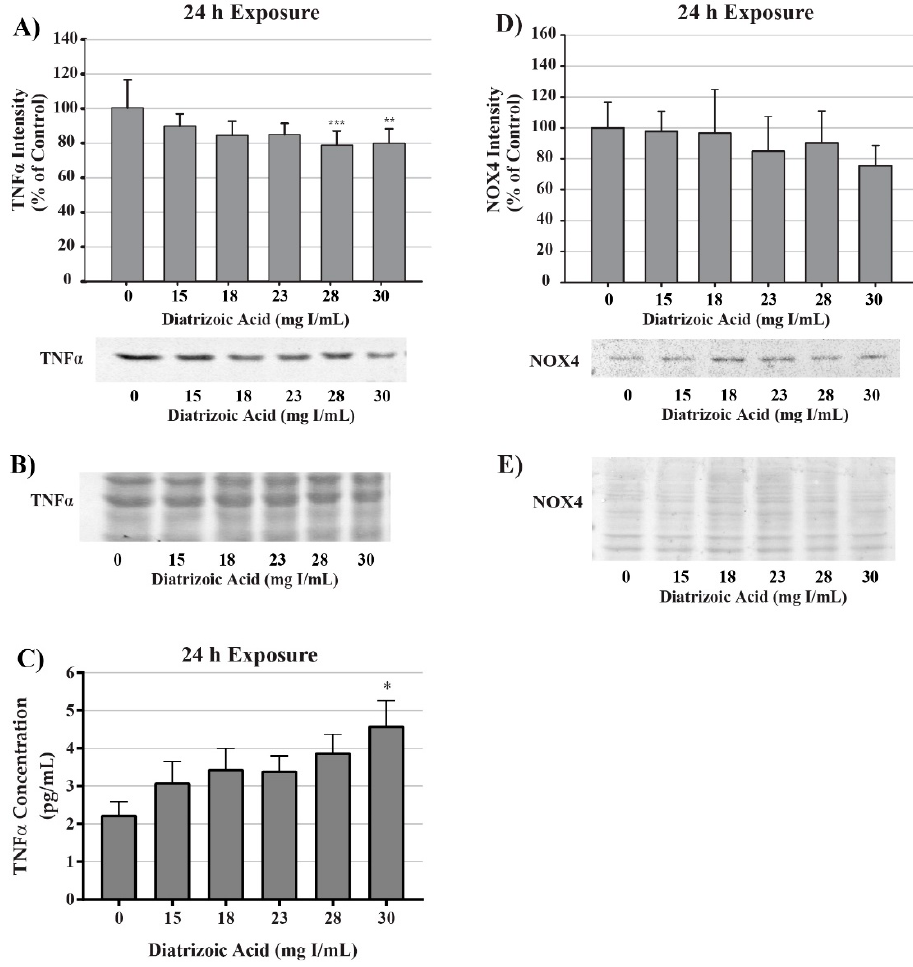
Figure 15. Diatrizoic acid effects on tumor necrosis factor alpha (TNF α ) and NADPH oxidase (NOX4) expression in HK-2 cells. DA induced TNF α activation but did not affect downstream effectors. TNF α expression in cell lysate was decreased in response to 28 and 30 mg I/mL DA at 24 h ( A ). An increase in TNF α leakage into the cell media was evident at 24 h ( C ) with 30 mg I/mL DA. No significant change in NOX4 expression was apparent in cell lysate following 24 h ( D ) exposure to DA. Representative blot with Memcode reversible stain for 40 µg loaded protein depicted for TNF α ( B ) and NOX4 ( E ) following 24 h exposure. Statistical difference from 0 mg I/mL diatrizoic acid depicted by an asterisk (* p < 0.05, ** p < 0.01, *** p < 0.001) . Values represent mean ± SEM for three independent experiments.